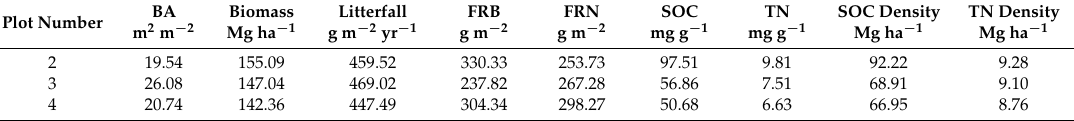
Table 1. Basic stand characteristics, soil organic carbon, and total nitrogen for the three plots. Plot